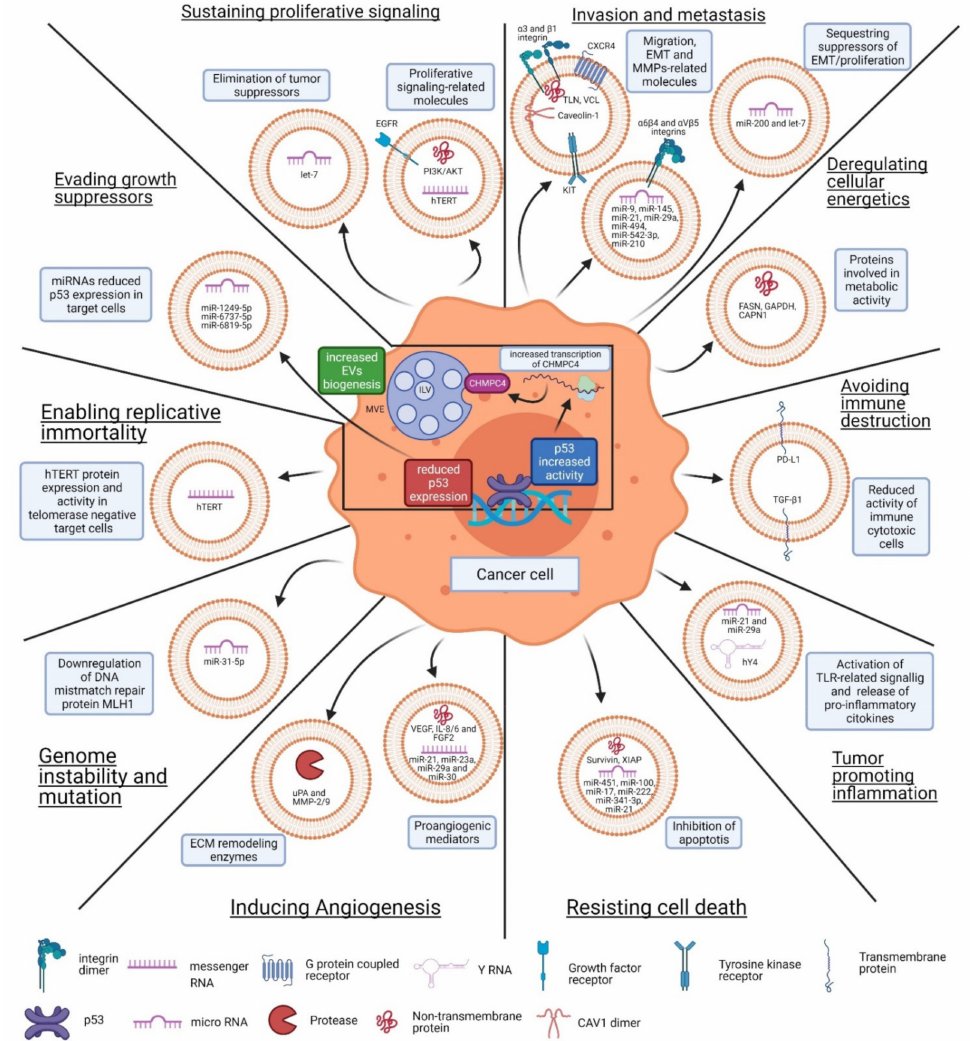
Figure 2. EV-mediated function in cancer. The term “hallmarks of cancer” described by Hanahan and Weinberg [56] refers to ten biological characteristics that are acquired by cancer cells during the multistep process leading to tumor development. The EV-mediated roles reported to date are shown here for each “hallmark of cancer”: Sustaining proliferative signaling [57–63], Evading growth suppressors [64], Resisting cell death [65,66], Enabling replicative immortality [57,67],